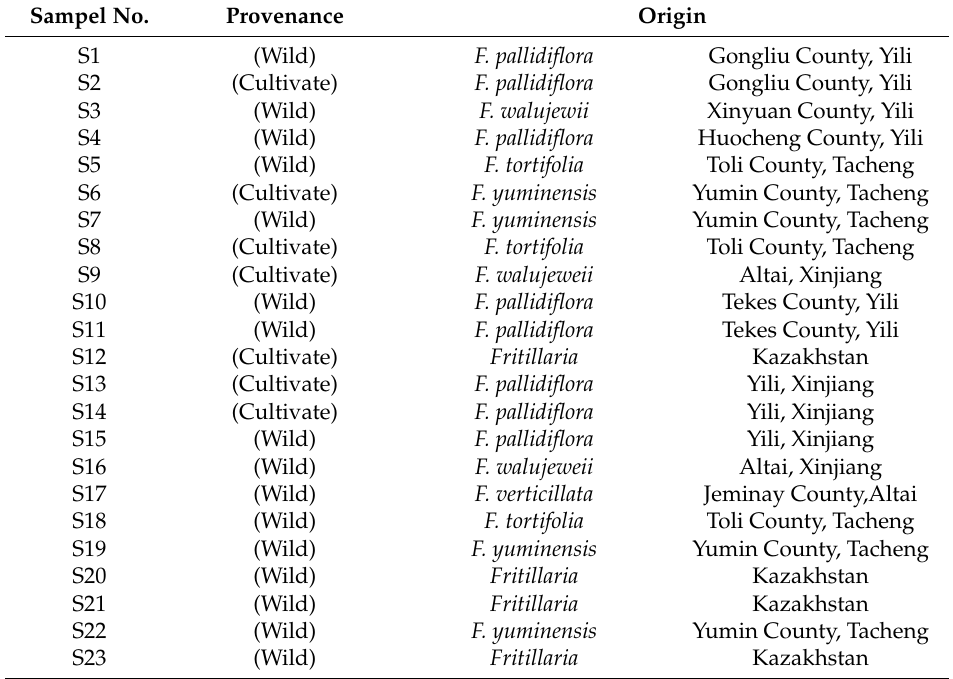
Table 3. Fritillaria